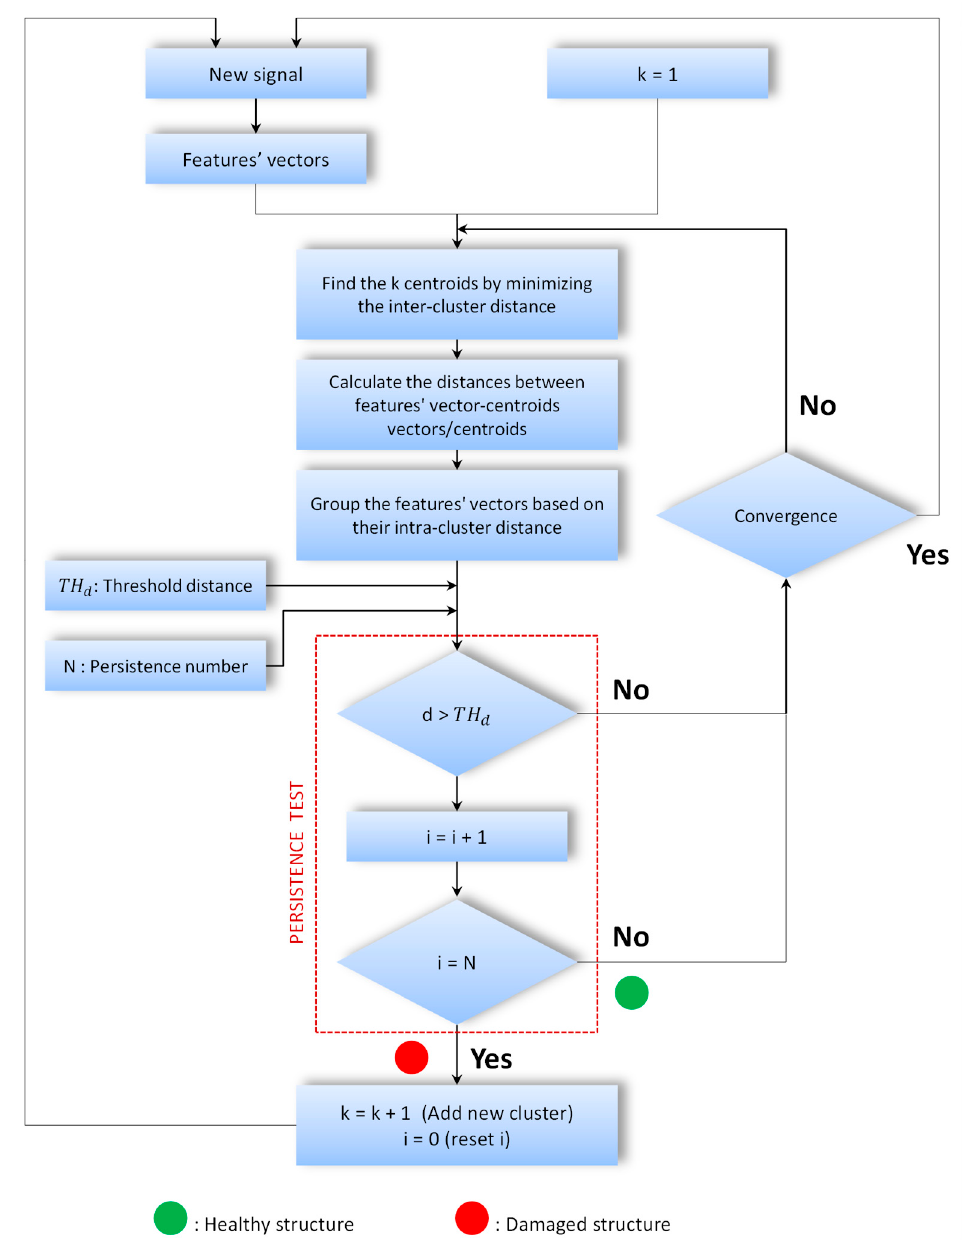
Figure 4. Proposed online clustering based on